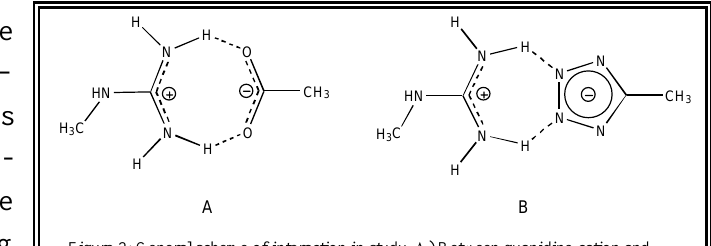
Figure 2: General scheme of interaction in study. A) Between guanidine cation and anion carboxylate. B) Between of guanidine cation and anión